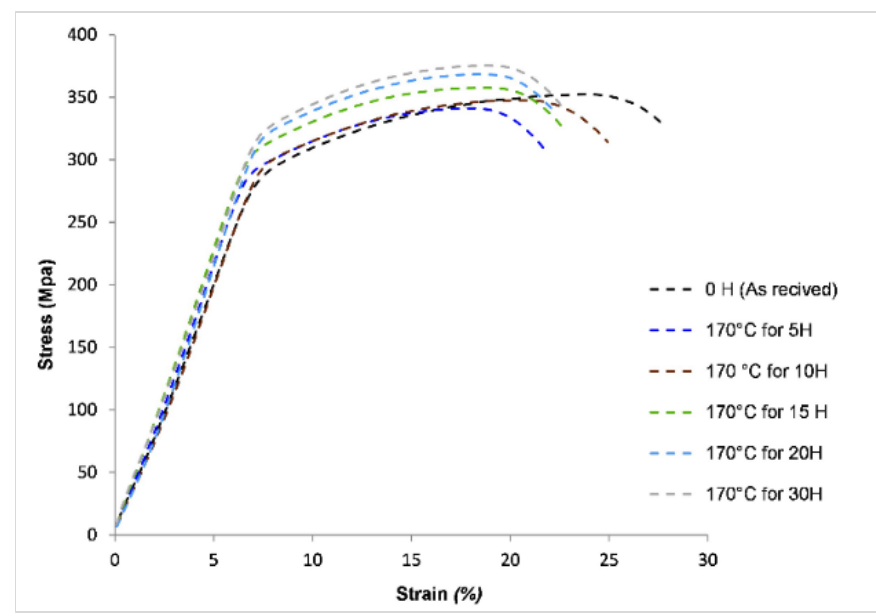
Fig. 6. Stress-strain curves of the 2017A-T4 alloy at different aging conditions.